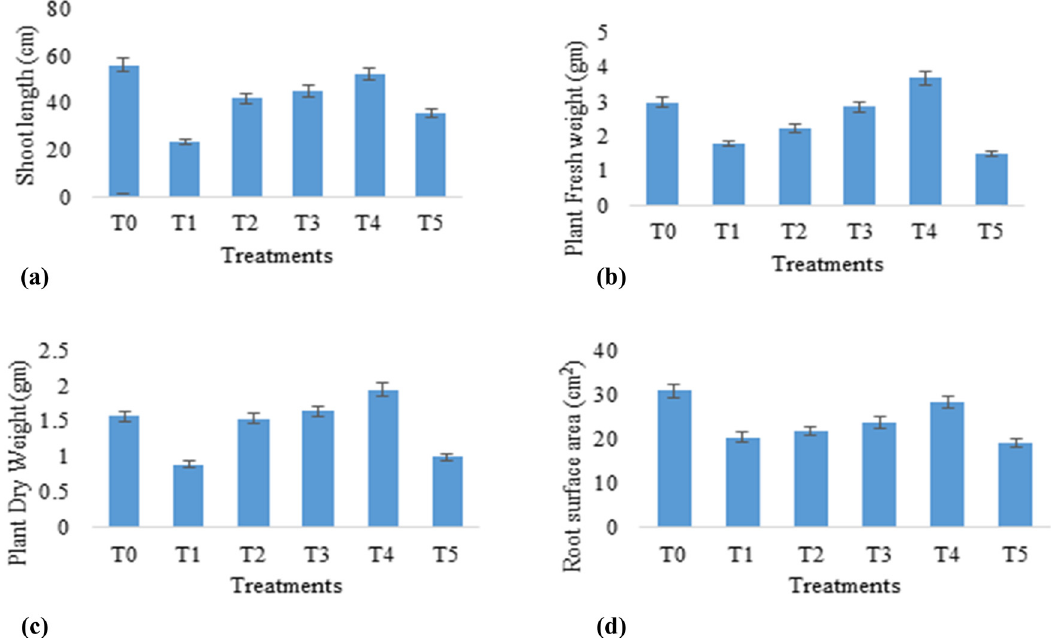
Figure 9: Morphological responses: ( a ) shoot length, ( b ) plant fresh weight, ( c ) plant dry weight, and ( d ) root surface area of wheat plants under P. striiformis stress in response to various concentrations of AgNPs: 25, 50, 75, and 100 mg · L − 1 . The data is presented as the mean ± S.D from three independent biological replicates. The error term is mean square error = p ≤